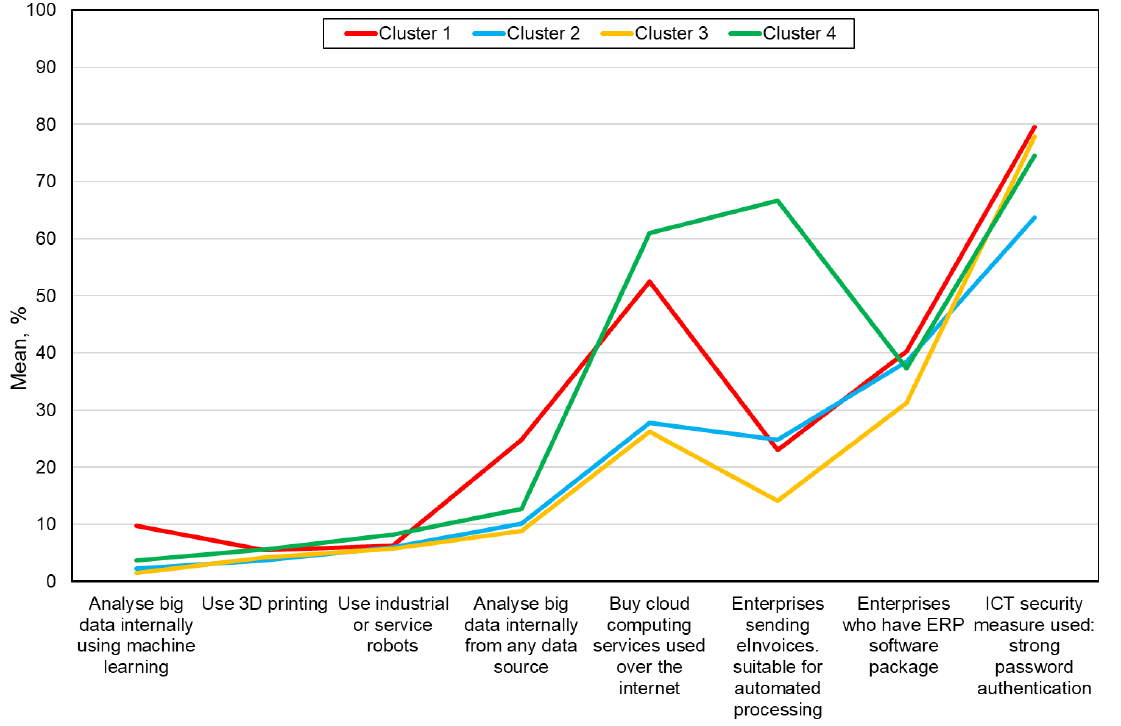
Figure 3. Summary of the mean values of the determinants of digital business maturity in the EU countries in individual clusters (own elaboration).